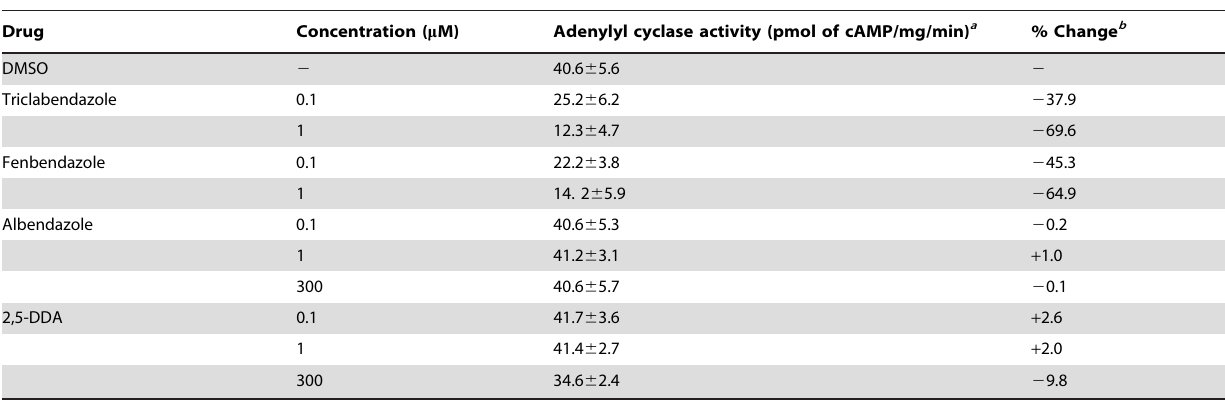
Table 2. Adenylyl cyclase activity in a plasma membrane extract.